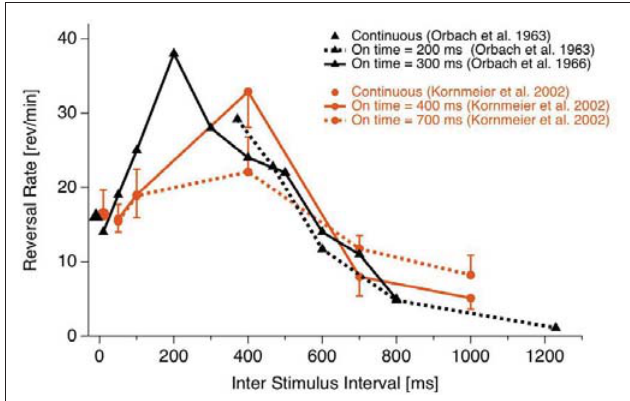
FIGURE 3 | Reversal rate as a function of ISI. Reversal rates with continuous and discontinuous presentations of ambiguous Necker stimuli from different studies. Reversal rates behave non-monotonically, increasing with ISI up to 400ms.Thereafter they decrease with further increasing ISIs. (Fig from Kornmeier et al., 2007,